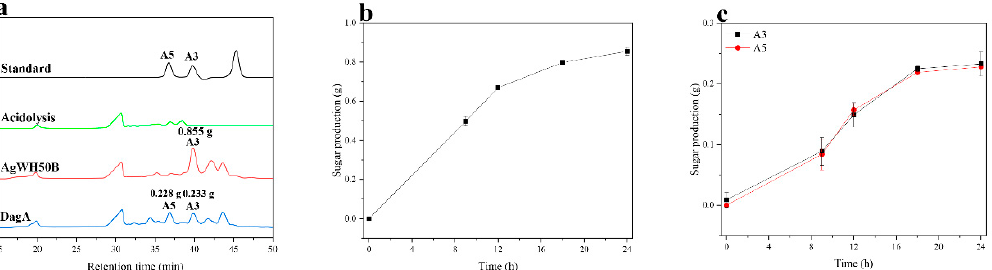
Figure 5. HPLC analysis of AOSs production during the chemical-biological route ( a ). Time-course of the product formation during the processes of enzymatic hydrolysis by AgWH50B ( b ) or DagA ( c ). The value of each point was the mean of three experiments (n = 3). Error bars represent one standard deviation of triplicate measurements.